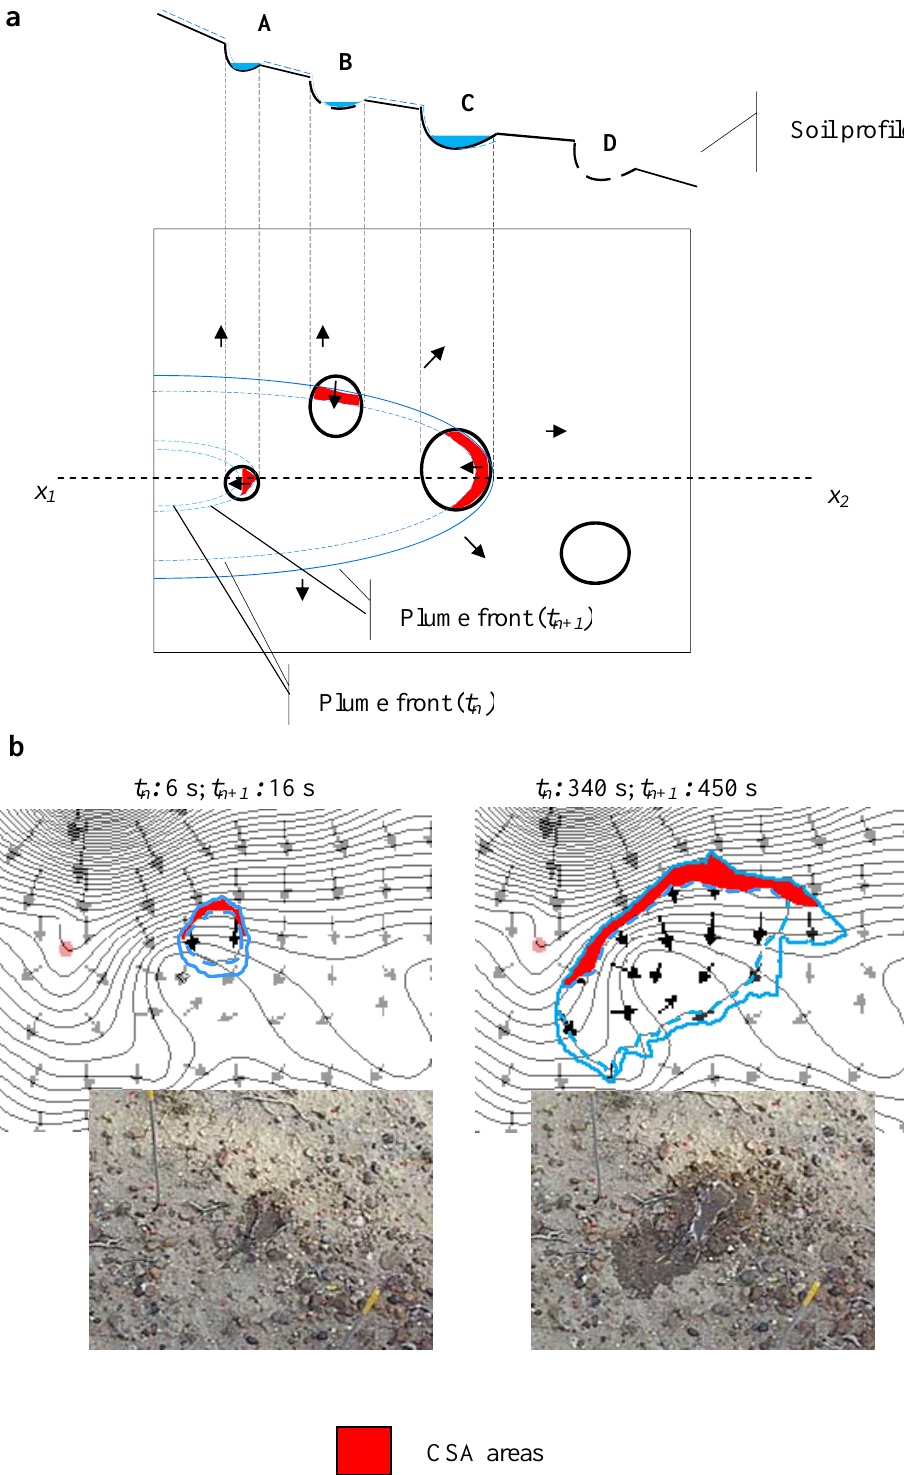
Fig. 2. Estimation of local CSA (Counter-Slope-Advance) overland plume areas in this study. (a) An example of a soil profile at x 1 − x 2 with micro-depressions (A–D). An overland plume advances down-slope from left to right up to depression C , over totally ponded A–C and partially ponded B. Plume fronts circumscribe plume areas A(t)(n) and A(t)(n + 1 ) (see Eqs. 1–2). Part (red areas) of the plume advances occur up-slope while the plumes fill depressions and finally overflow the depression boundaries. (b) Scene examples (lower insets) of plume advances at Plot #10 at two sampling intervals. Left panel: t n : 6s, t n + 1 :16s; right panel: t n : 340s, t n + 1 : 450s after water inflow start, overlaid on the plot DEM (contour interval: 1mm) with DEM-based flow